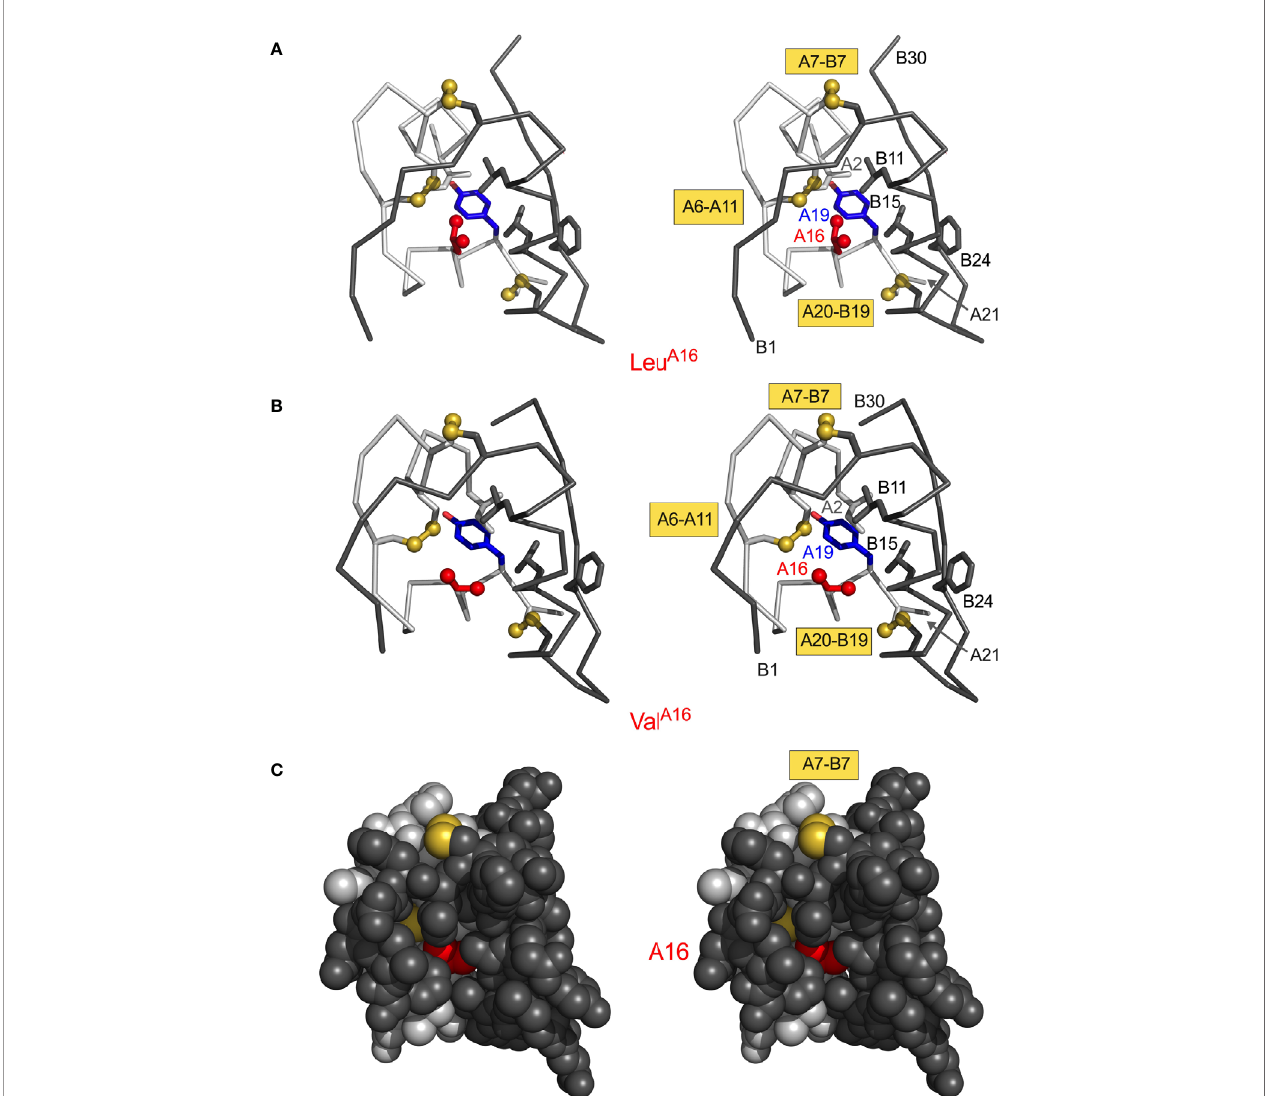
FIGURE 5 | Structural environment of conserved position A16. (A) Leu A16 packs in core of insulin monomer: ribbon model (stereo pair) showing Leu A16 (red) in relation to Tyr A19 (blue) and internal side chains Ile A2 (light gray), Leu B11 (dark gray) and Leu B15 (dark gray). A- and B-chain ribbons are shown in light- and dark gray, respectively; disul fi de bridges are shown as gold spheres. Molecular coordinates were obtained from PDB entry 4INS (47). (B) Corresponding ribbon model (same orientation) of “ non-foldable ” analogue Val A16 (PDB entry 3GKY) (156). Structural similarities highlight cryptic folding defect. (C) Stereo space- fi lling model showing limited exposure of internal Val A16 side chain (red) between B-chain surface (dark gray, overlying surface) and A-chain surface (light gray). The solvent-exposed A7 – B7 disul fi de bridge is shown in gold (top); internal cystine side chains A6 – A11 and A20 – B19 are not